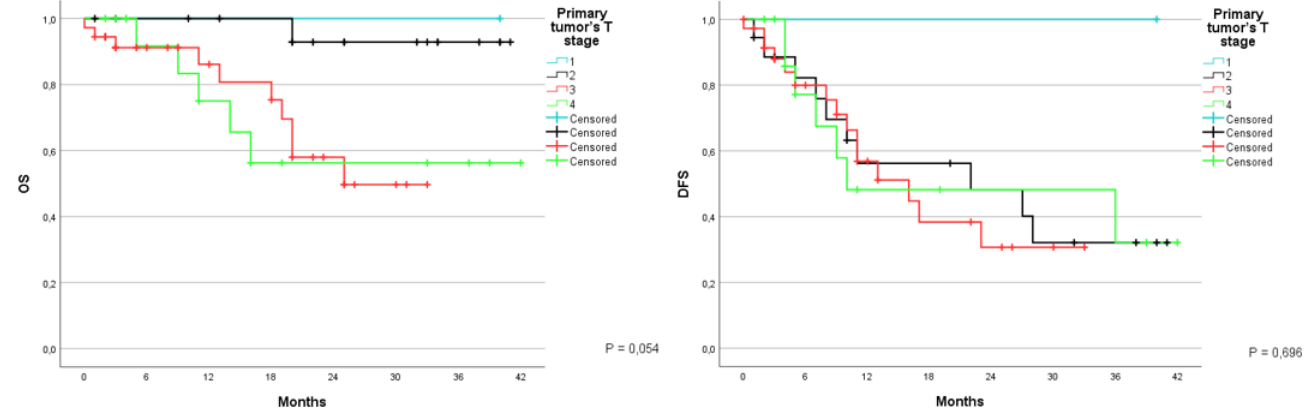
Figure 2. Kaplan-Meier curve for OS and DFS in patients who underwent liver resection for CRLM stratified based on the primary tumor site. (Left colon, right colon, rectum). OS: Overall Survival; DFS: Disease Free Survival; CRLM: Colorectal liver metastases.